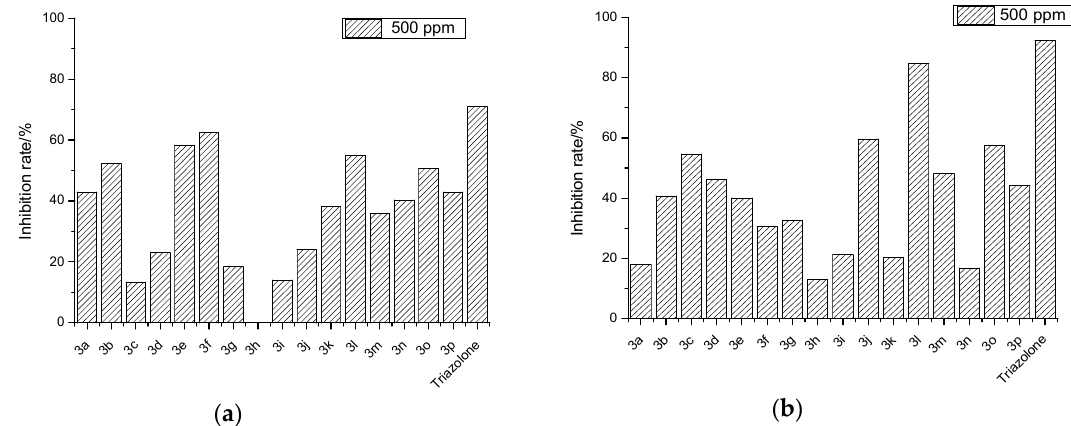
Figure 3. Antifungal activity of the target compounds 3 a – p , against— Fusarium graminearum ( a ) and Fusarium monitiforme ( b ) . Fusarium monitiforme ( b